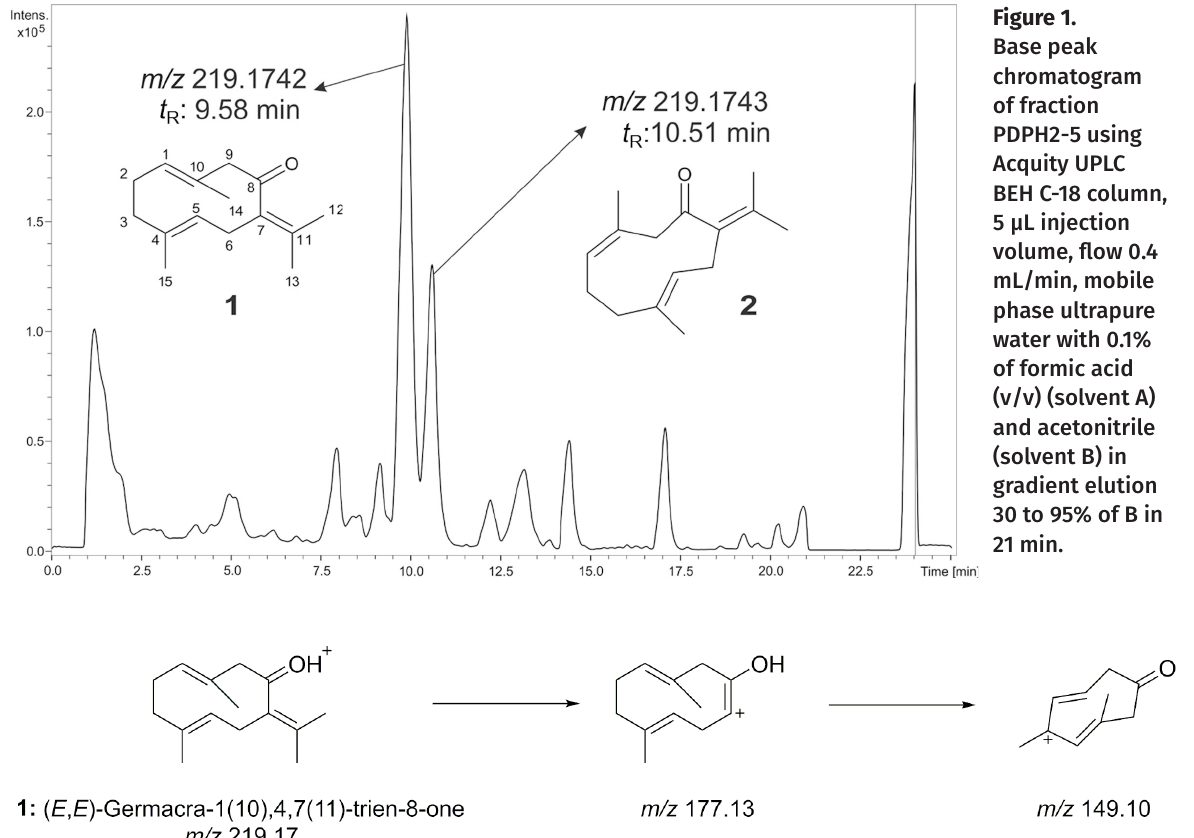
Figure 2. Proposed fragmentation pathways of ( E , E )-germacra-1(10),4,7(11)-trien-8-one (1).